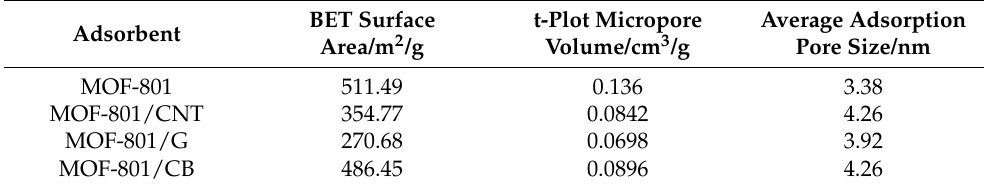
Table 1. Comparison of adsorbent microstructure